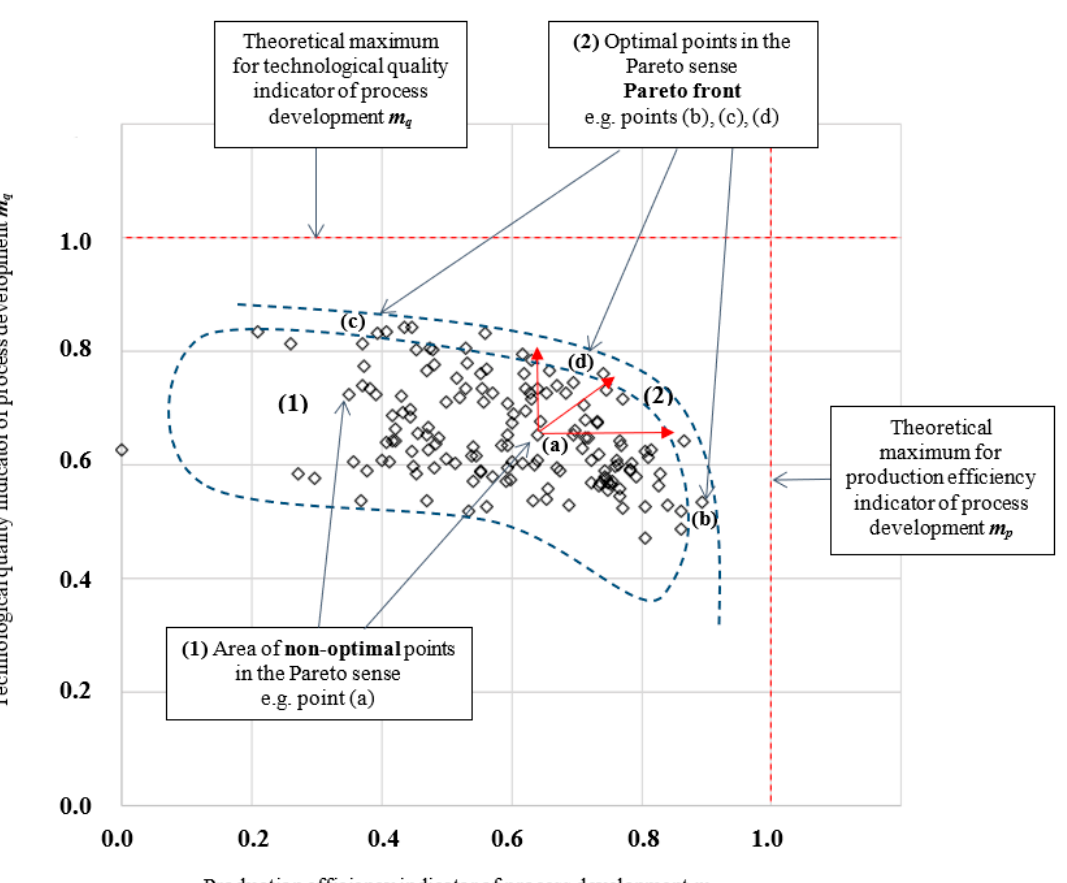
Figure 3. Analysis of optimality in the Pareto sense ( m p vs. m q for 4-h periods registered within 1